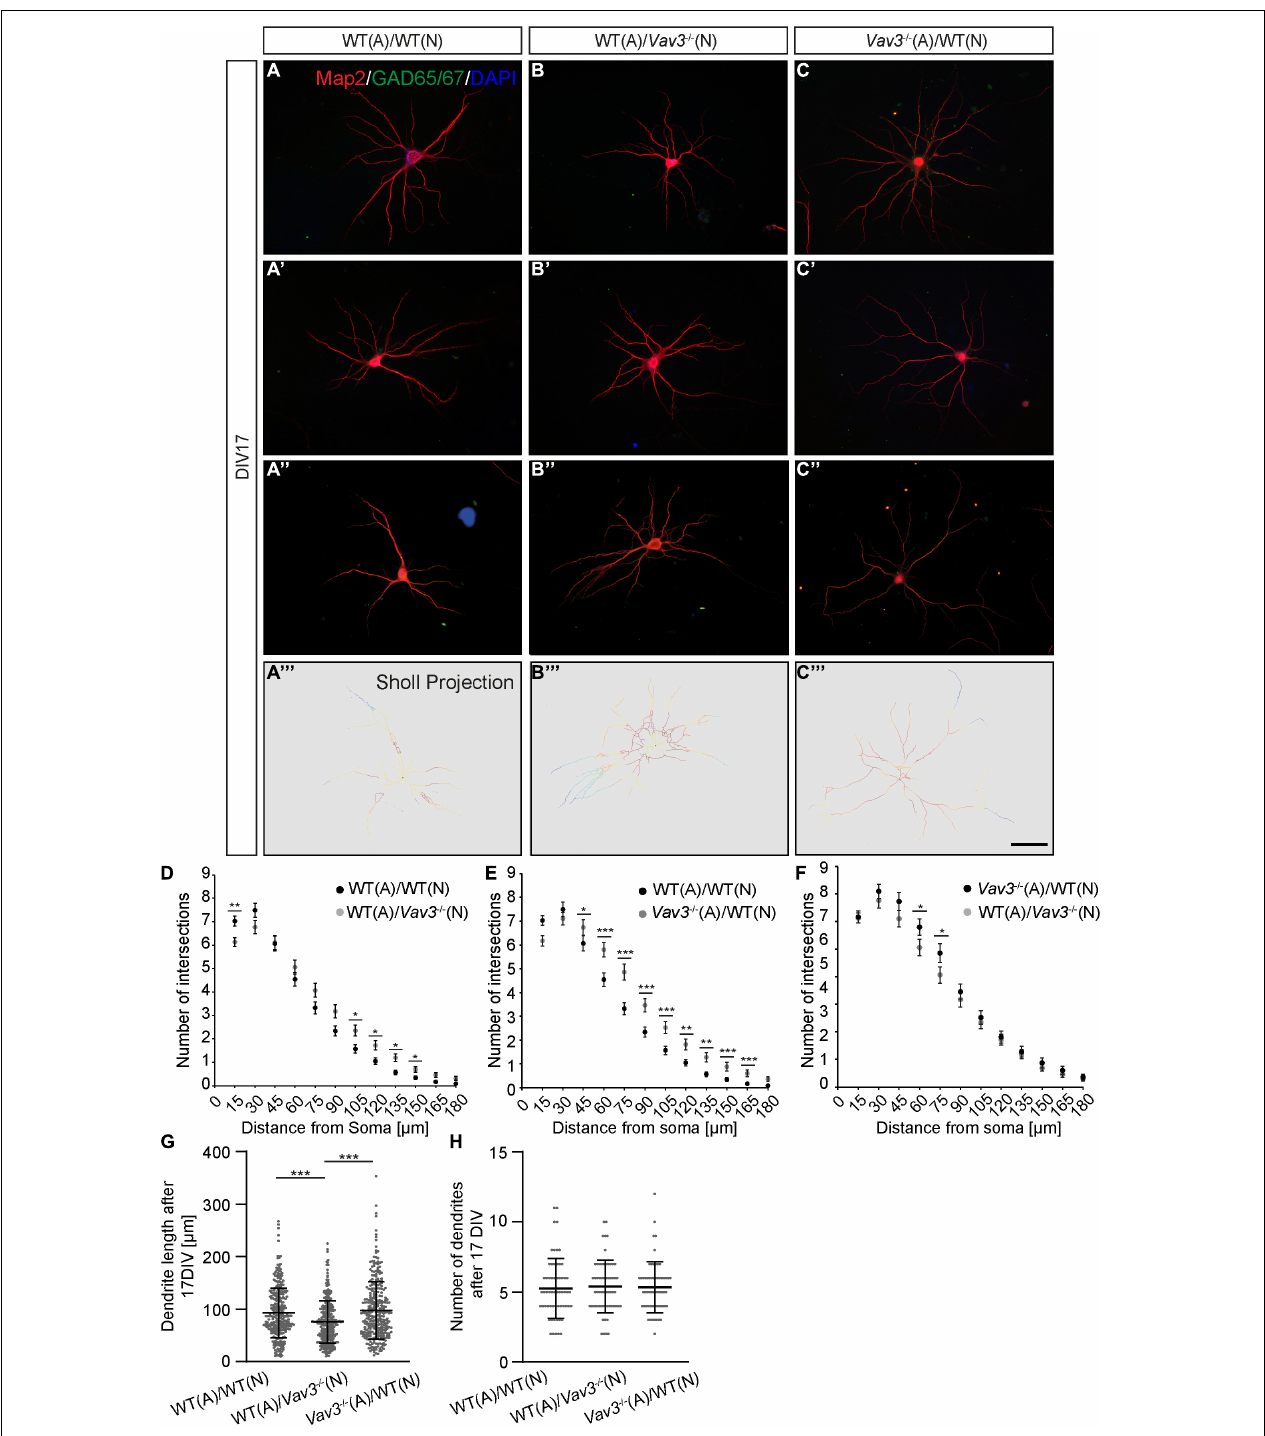
FIGURE 3 | (A–A”,B–B”,C–C”) Neurons of the different combinations were fixed after a culturing time of 17 days and immunostained against Map2 and GAD65/67. As previously mentioned GAD65/67 positive neurons were excluded from the analysis since interneurons possess a strongly differing morphology compared to pyramidal neurons. DAPI was utilized for the visualization of nuclei. Three exemplary neurons are shown per condition. (A”’–C”’) The Sholl projection represents the skeletonized dendrites and depicts highly branched regions with a red labeling while less branched regions are marked by a blue labeling. (D–F) After a culturing time of 17 days in vitro wildtype neurons which were kept in culture with Vav3 − / − astrocytes showed a significantly increase in the number of intersections at nearly all analyzed distances from the soma. Furthermore, Vav3 − / − neurons developed a higher number of intersections in the distal part of the dendrites. (G) Vav3 − / −